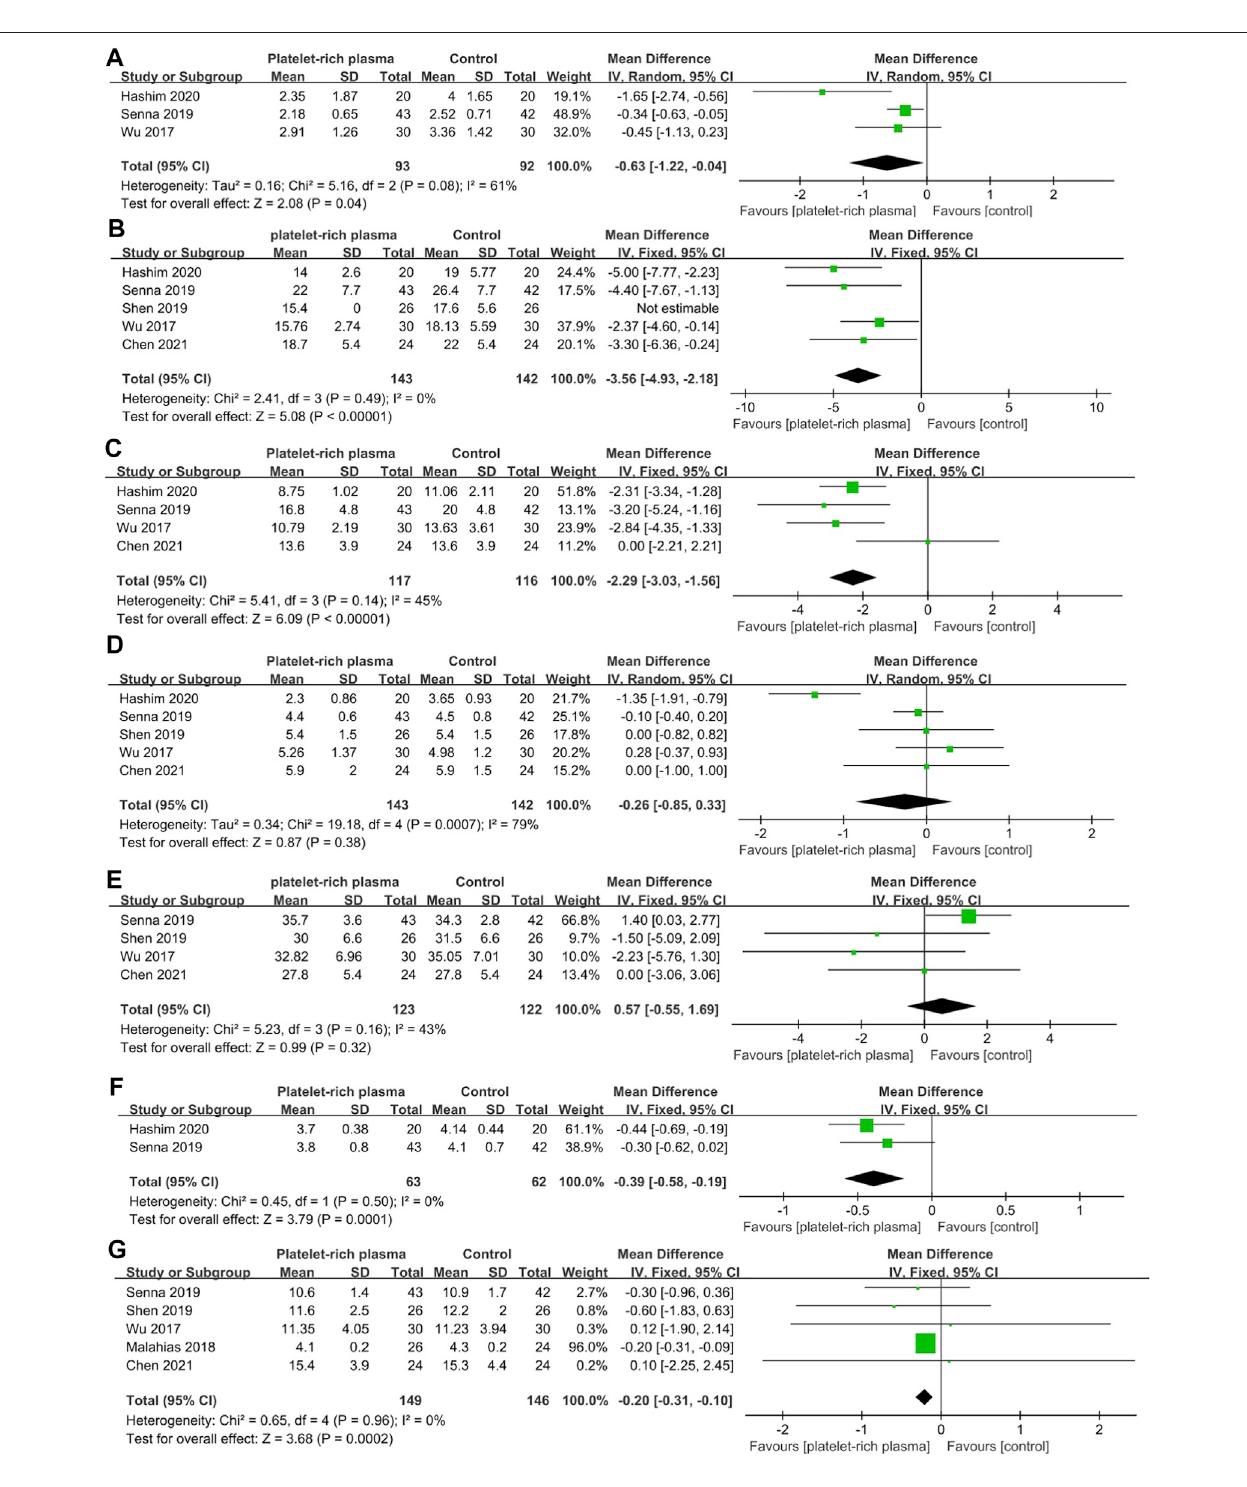
FIGURE 5 | Forest plot showing mid-term ef fi cacy of local platelet-rich plasma injection versus other conservative treatments. (A) Visual analogue scale. (B) Symptomseverityscale. (C) Functional status scale. (D) Distal motor latency. (E) Sensory nerveconduction velocity. (F) Sensorypeak latency. (G) Cross sectional area.